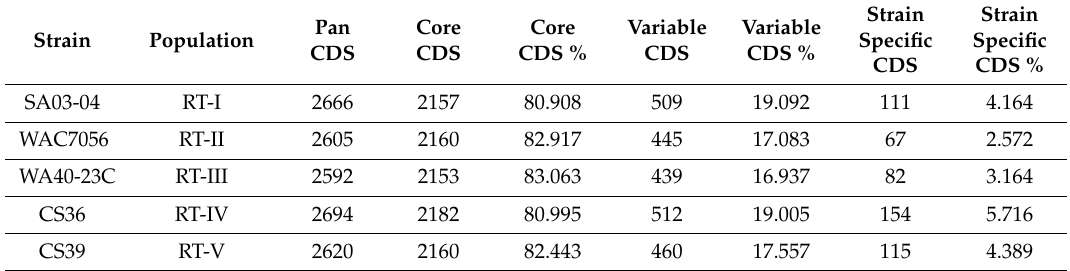
Table 2. Genome analysis of representative strains of R. toxicus populations by